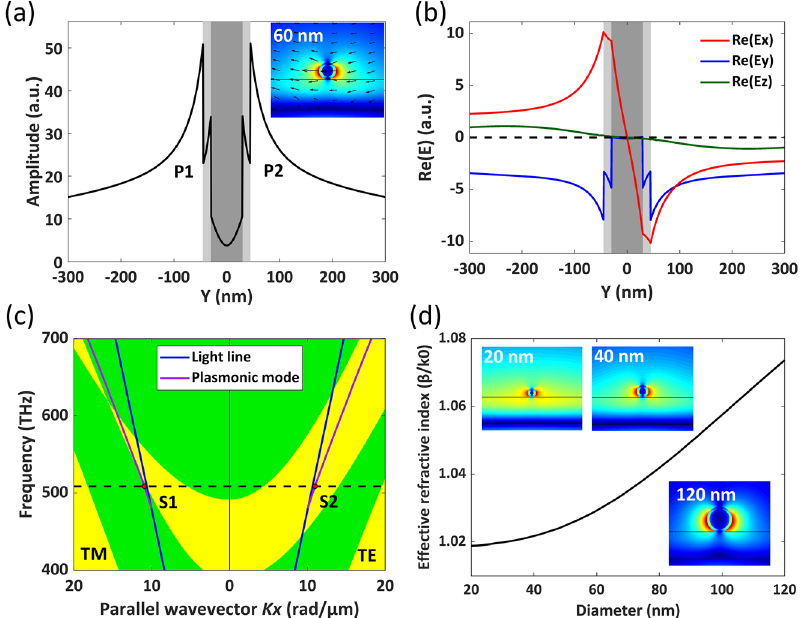
Figure 3: Numerical simulation of the plasmonic mode. (a)Theprofileoftheelectricfieldamplitude( | E | )acrossthecenteroftheAgNW.Thisinsetgraphshowstheelectric fi eldamplitudedistribution aroundtheAgNWwithadiameterof60nm.Theblackarrowsintheinsetgraphsdenotethedirectionoftheelectric fi eldvector.(b)Thepro fi les of the real part for three electric fi eld components (Ex, Ey and Ez) across the center of the Ag NW (inset graph on (a)). (c) The projected band structure of the dielectric multilayer for TE and TM polarizations. The yellow zone denotes the forbidden band. The green zone denotes the conductionband.Thebluelinedenotesthelightlineintheair.Thepurplelinedenotesthedispersionrelationfortheplasmonicmode.Thered spots (S1 and S2) on purple line correspond to the excitation wavelength at 590 nm. (d) The effective refractive index for the plasmonic mode versus the diameter of an Ag NW. The electric fi eld amplitude distributions for the plasmonic mode of an Ag NW with diameters of 20, 40 and 120 nm are shown in the inset